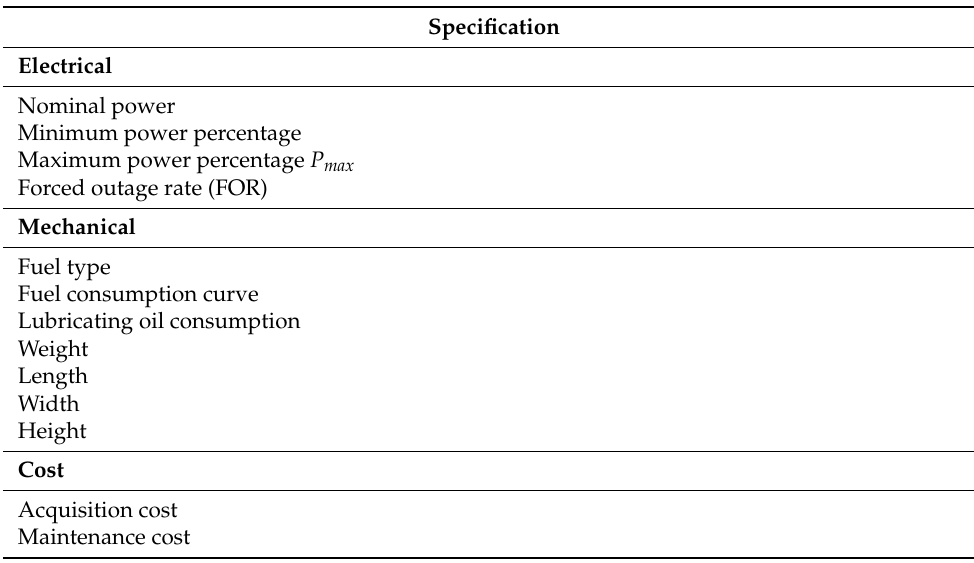
Table 1. Generator data collected.